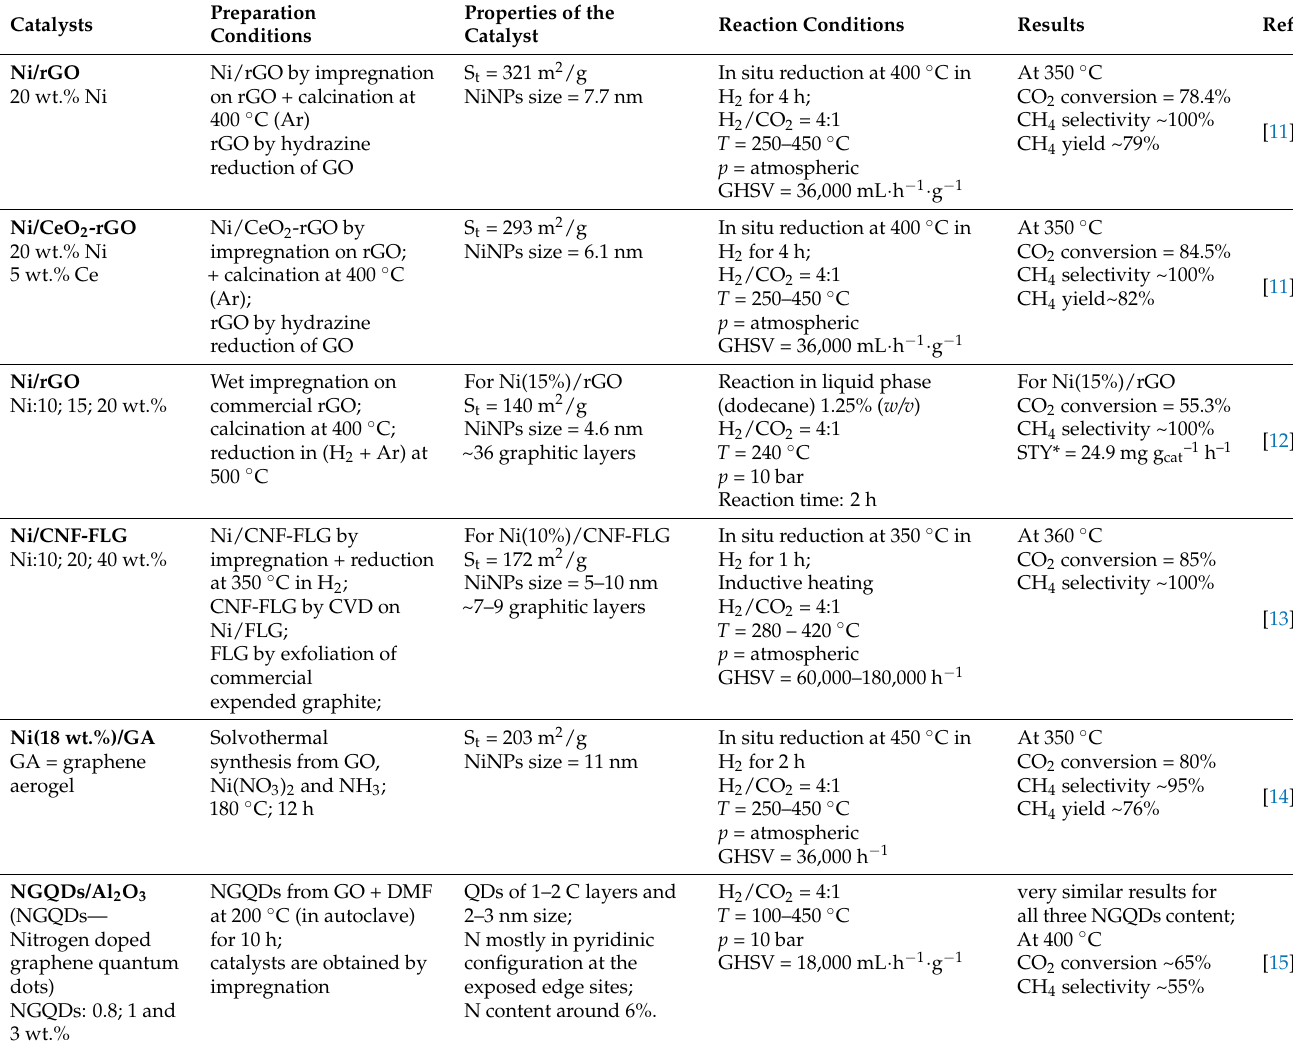
Table 1. Graphene-based catalysts for CO 2 hydrogenation to